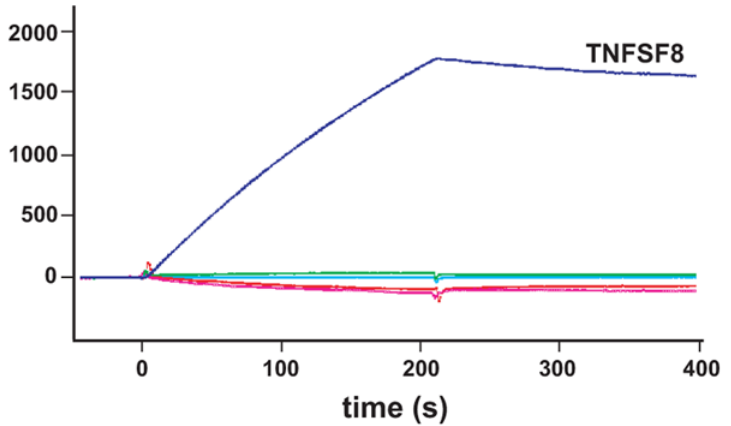
Figure 3. ECTV vCD30 ligand screening. Sensorgram showing binding of mTNFSF8 (CD30L) injected at 50 nM to purified vCD30 coupled to a CM5 sensor chip by SPR analysis. TNFSF10 (pink line), TNFSF11 (cyan line), TNFSF12 (red line) and TNFSF14 (green line) injected at 100 nM each did not show interaction.